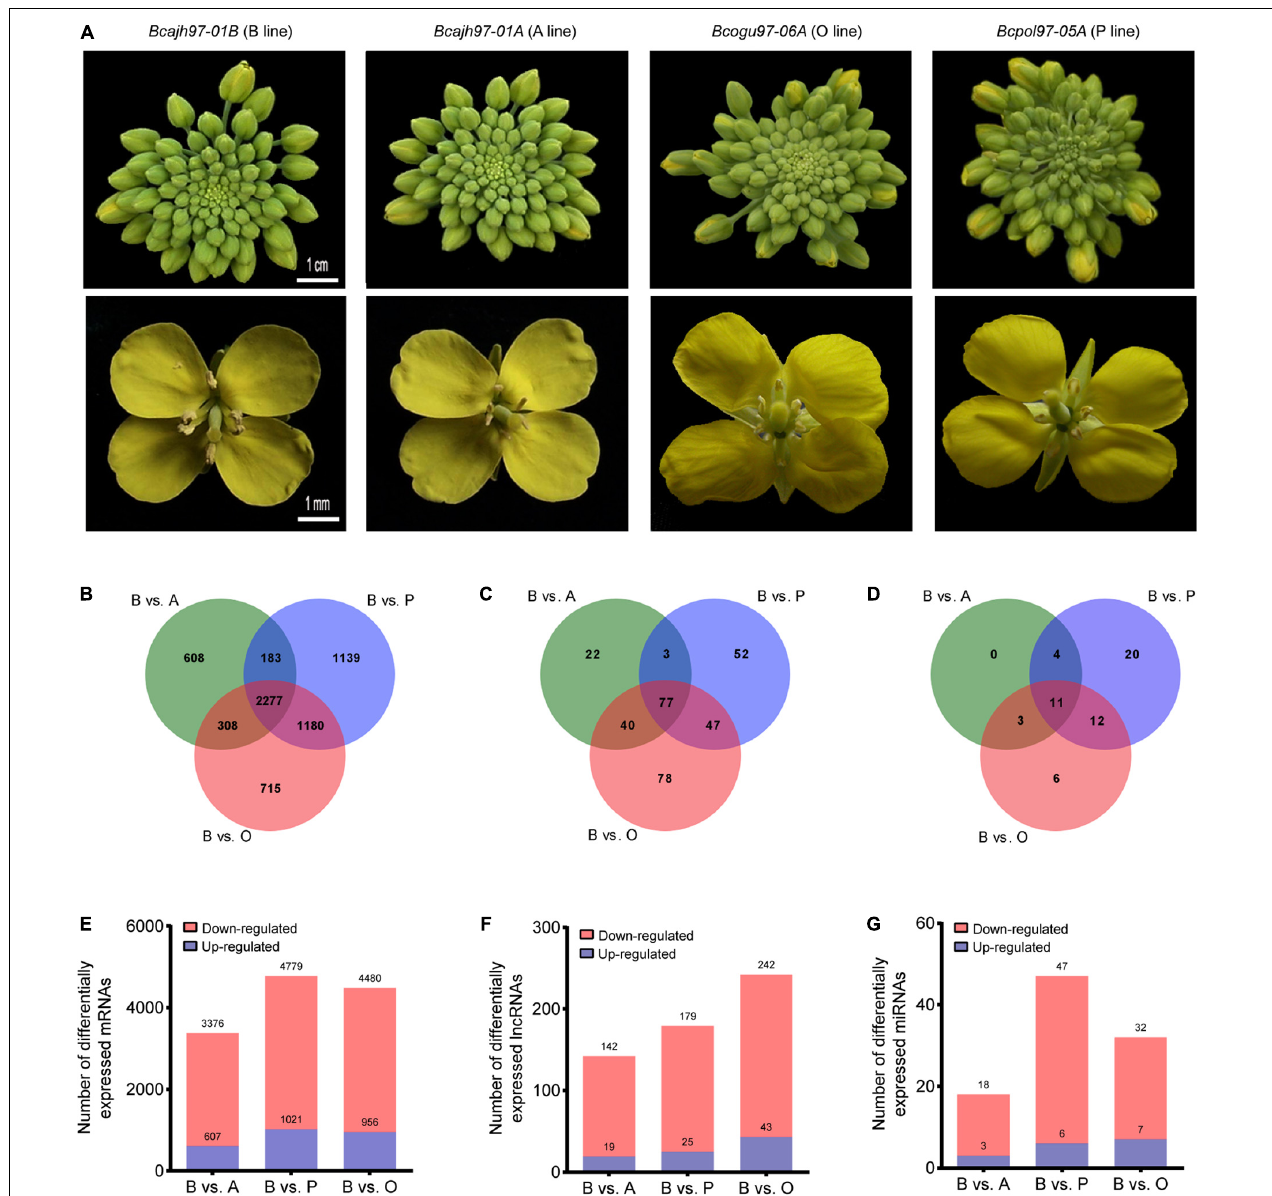
FIGURE 1 | Genome-wide identification and characteristics of transcripts in Brassica campestris . (A) Photographs for inflorescences and flowers from the sterile and the fertile line. (B,E) Statistics of differentially expressed mRNAs in three sterile lines and the fertile line. (C,F) Statistics of differentially expressed long non-coding RNAs in three sterile lines and fertile line. (D,G) Statistics of differentially expressed microRNAs in three sterile lines and fertile line. B line, the maintainer line ‘ Bcajh97-01B ’; A line, the genic male-sterile line ‘ Bcajh97-01A ’; P line, Polima cytoplasmic male-sterile line ‘ Bcpol97-05A ’; O line, Ogura cytoplasmic male-sterile line ‘ Bcogu97-06A